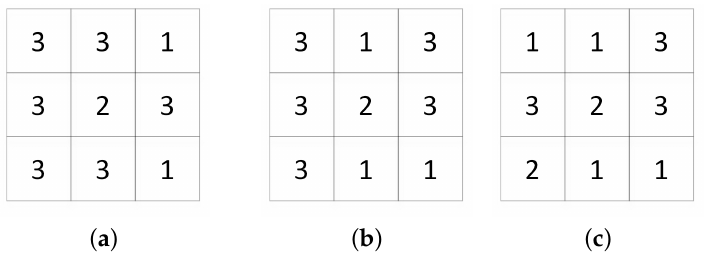
Figure 3. PixS to be refined in three different